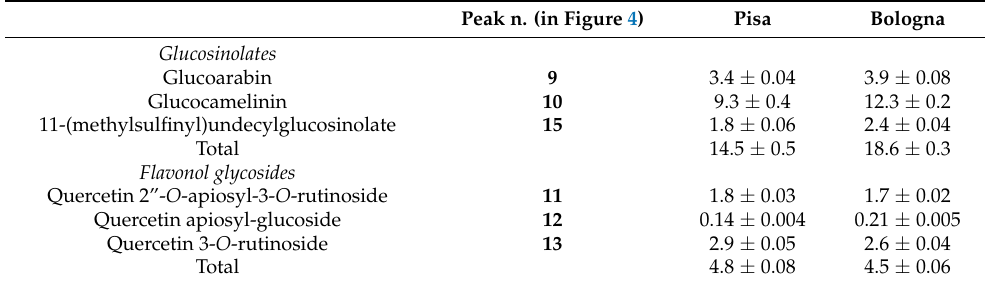
Table 5. Quantitative amount (mg/g ± SD DW) of constituents found in meal extracts from Camelina sativa Italia in two cultivation sites, Pisa and